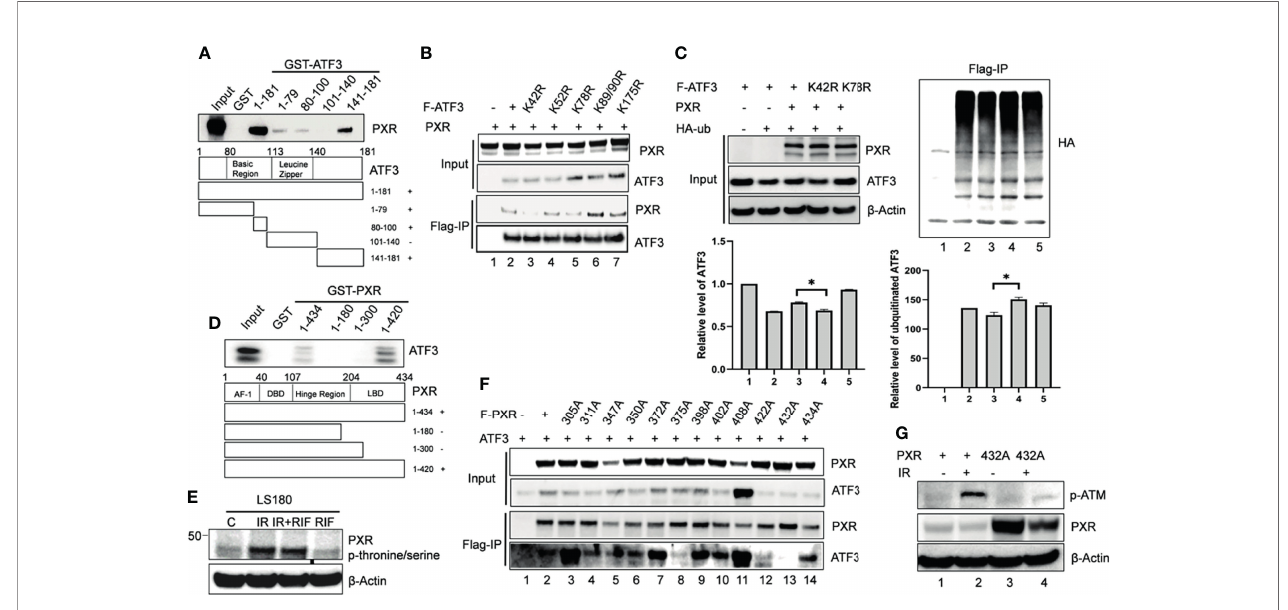
FIGURE 3 | The PXR-ATF3 interaction is required for ATF3 regulation. (A) Identi fi cation of ATF3 domains for PXR binding. 1 m g ATF3 truncated proteins fused to GST were immobilized onto glutathione agarose beads and incubated with 5 m l in vitro translated PXR for GST-pulldown assays. The pulled-down proteins were detected by Western blotting using the PXR antibody. (B) The ATF3 K42R mutation signi fi cantly reduced the binding between ATF3 and PXR. H1299 cells were transfected with 1.5 m g FLAG-ATF3 wild type or mutants, and 1.5 m g PXR as indicated for 2 days. FLAG-immunoprecipitation (IP) assays were performed using FLAG antibody to precipitate. (C) The ATF3 K42 was essential for ubiquitination of ATF3 regulated by PXR. H1299 cells were transfected with 1 m g FLAGATF3 wild type or mutants, and 2 m g HA-ubiquitin, and/or 4 m g PXR as indicated for 2 days, and then subjected to FLAG-IP assays using FLAG antibody to precipitate *p < 0.05. (D) Mapping of PXR domains/regions for ATF3 binding. 1 m g PXR truncated proteins fused to GST were immobilized onto glutathione agarose beads and incubated with 5 m l in vitro translated ATF3 for GST-pulldown assays. The pulled-down proteins were detected by Western blotting using the ATF3 antibody. (E) Irradiation- induced signi fi cant increases in the phosphorylation of threonine/serine in PXR in colon cancer cells. LS180 cells were treated with 10 m M rifampicin (RIF) for 12 h, then radiated at a dose 10 Gy for 4h, PXR antibody was used to immunoprecipitate, then anti- Phosphor - (Ser/Thr) Phe antibody (ab17464) was used to blot. (F) The PXR T432A mutation signi fi cantly reduced the binding between ATF3 and PXR as determined by FLAG-IP. H1299 cells were transfected with 1 m g FLAG-PXR wild type or mutants, and 2 m g HA-ubiquitin, and/or 1 m g ATF3 as indicated for 2 days, and then subjected to FLAG-IP assays using FLAG antibody to precipitate. (G) The PXR T432A mutation abolished ATM phosphorylation and activation induced by IR in colon cancer cells. LS180 PXR knockout cell was transfected with 1.5 ug PXR wildtype, or mutant for 2 days, and then subjected to 10 Gy of g - irradiation and harvested after 24 h. The protein levels were determined by Western blotting using the indicated